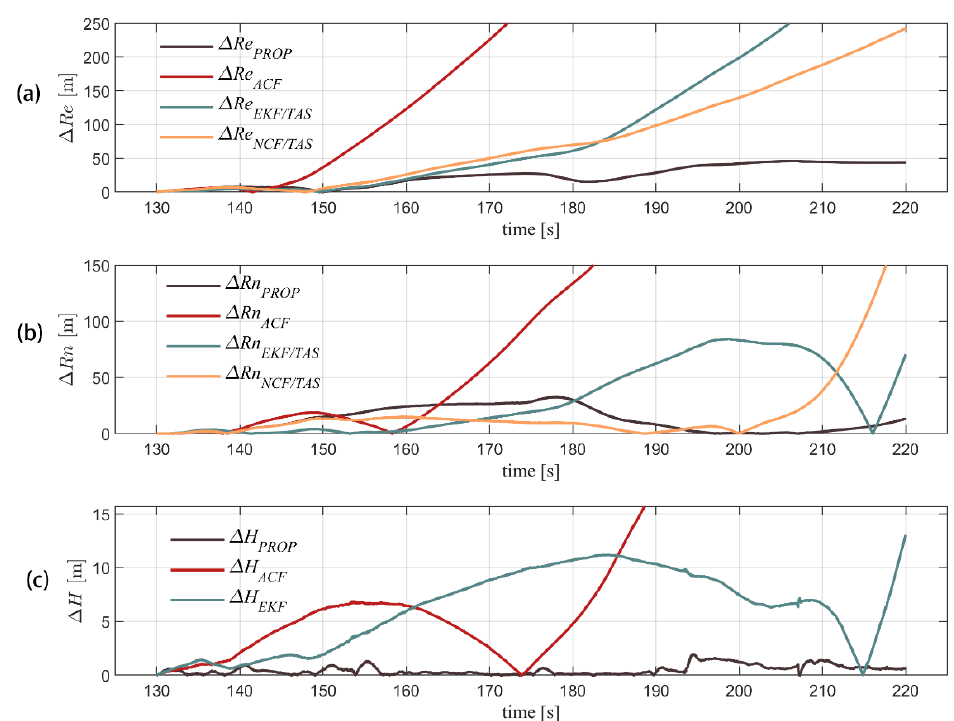
Figure 10. GPS navigation result is used as true values. Three-axis position error of the other four algorithms in flight is shown for east position, north position, and altitude error angle (from ( a – c ), respectively).